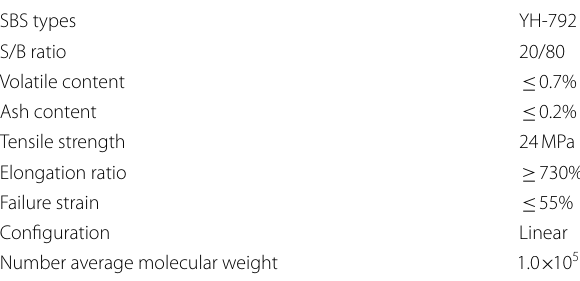
Table 2 Physichemical properties of the SBS modifier used